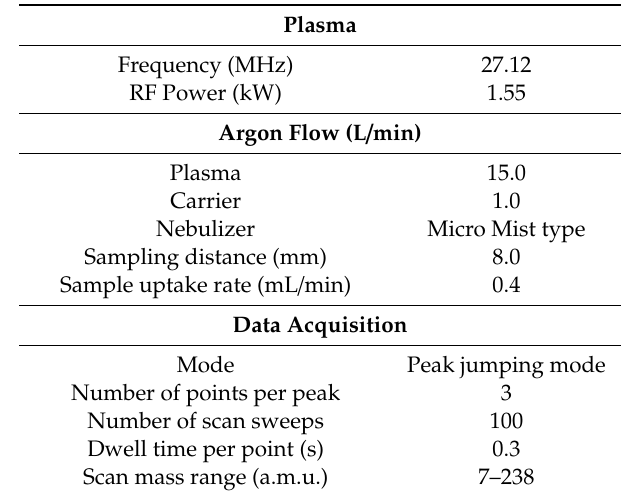
Table 5. Operating parameters for